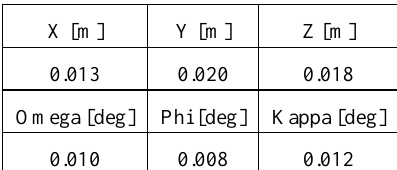
Table 1. Summary of the position accuracy at 17 check points